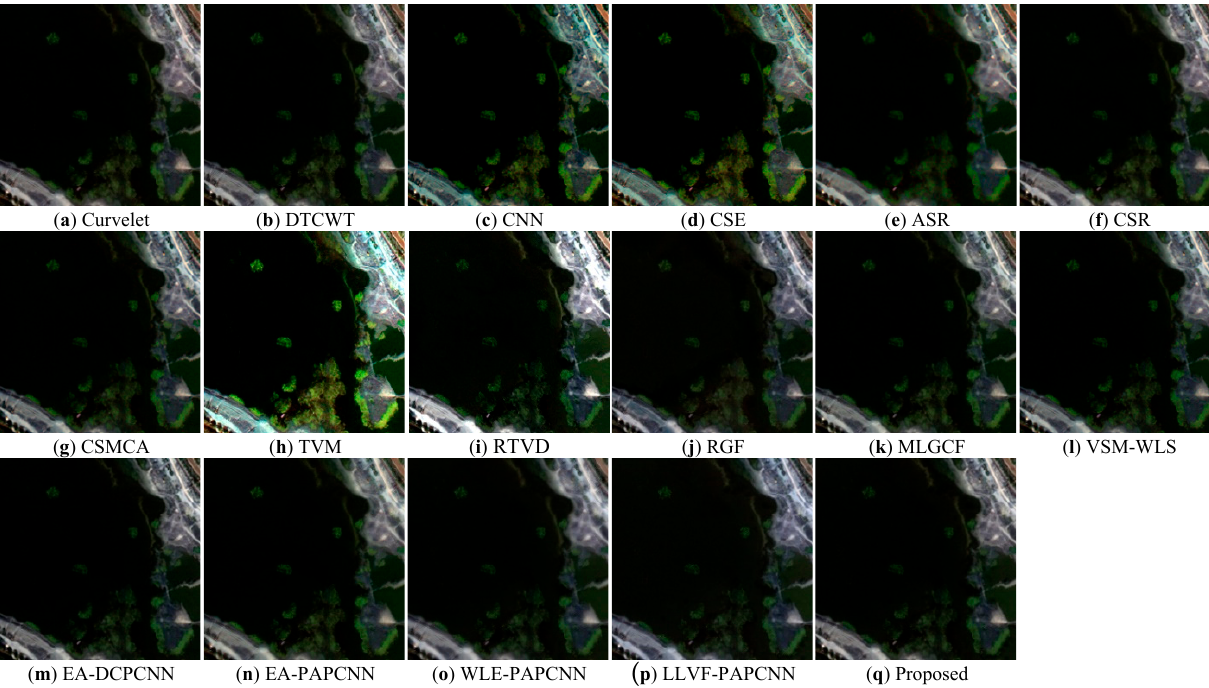
( q ) Proposed Figure 12. Error images corresponding to WorldView-3 images. It can be found that the spatial resolution of TVM, RTVD, ASR, CSR, and CSMCA fusion methods is low; in particular, ASR cannot identify the contours of some small